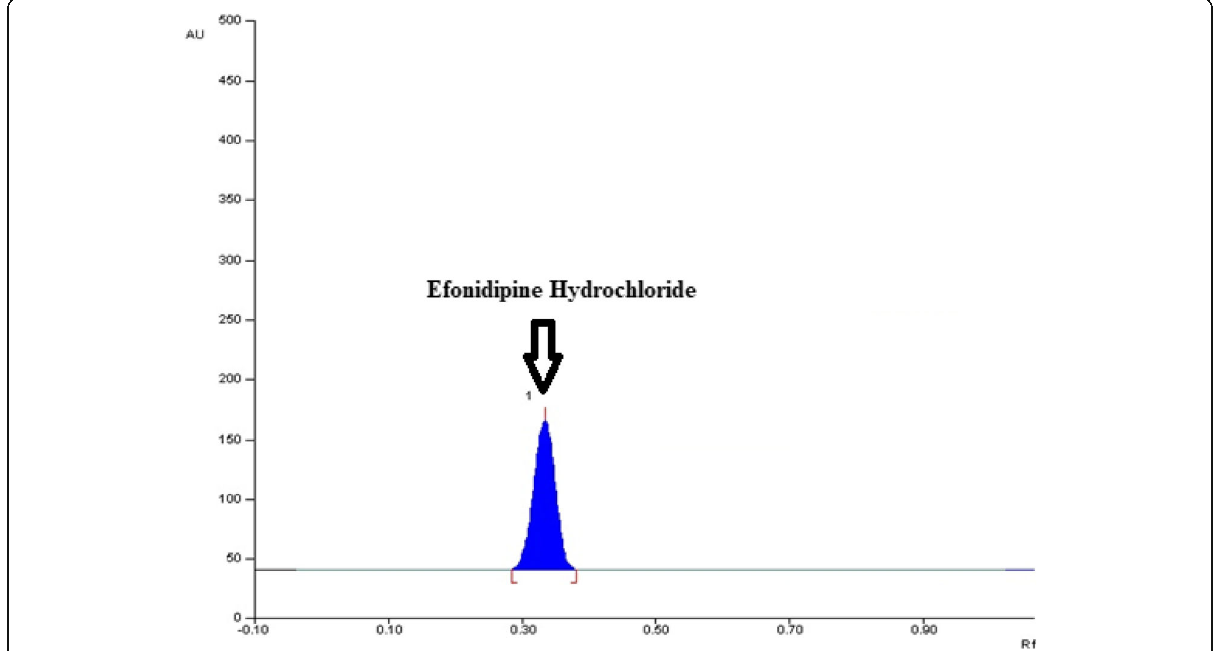
Fig. 5 Densitogram of EFH in ethyl acetate to dichloromethane to triethylamine solvent